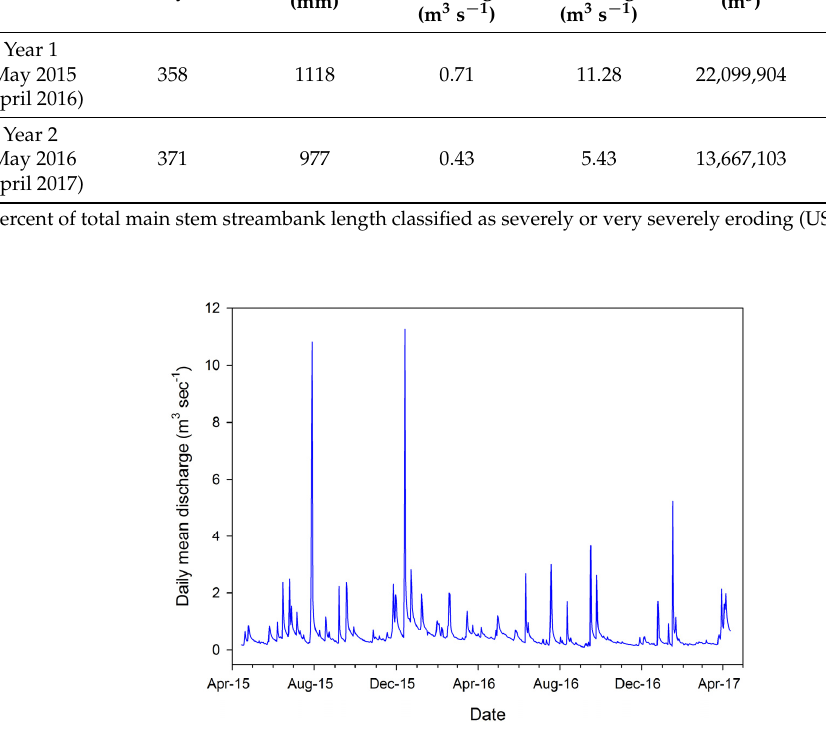
Table 2. Precipitation, hydrology, and eroding streambank length data for Walnut Creek, Iowa, for